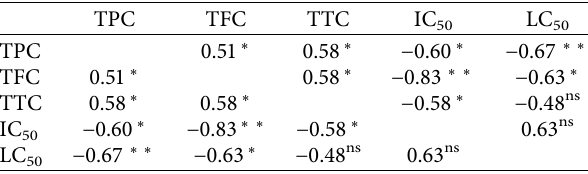
Table 9: Kendall rank correlation coefcient.